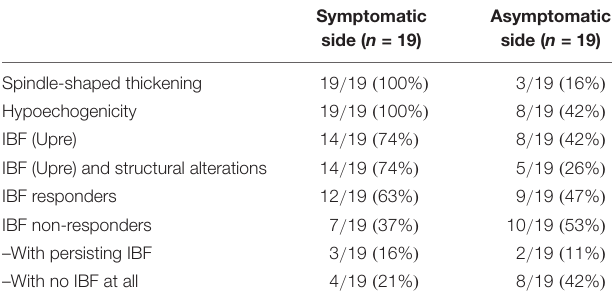
TABLE 1 | Tendon characteristics of the symptomatic and asymptomatic